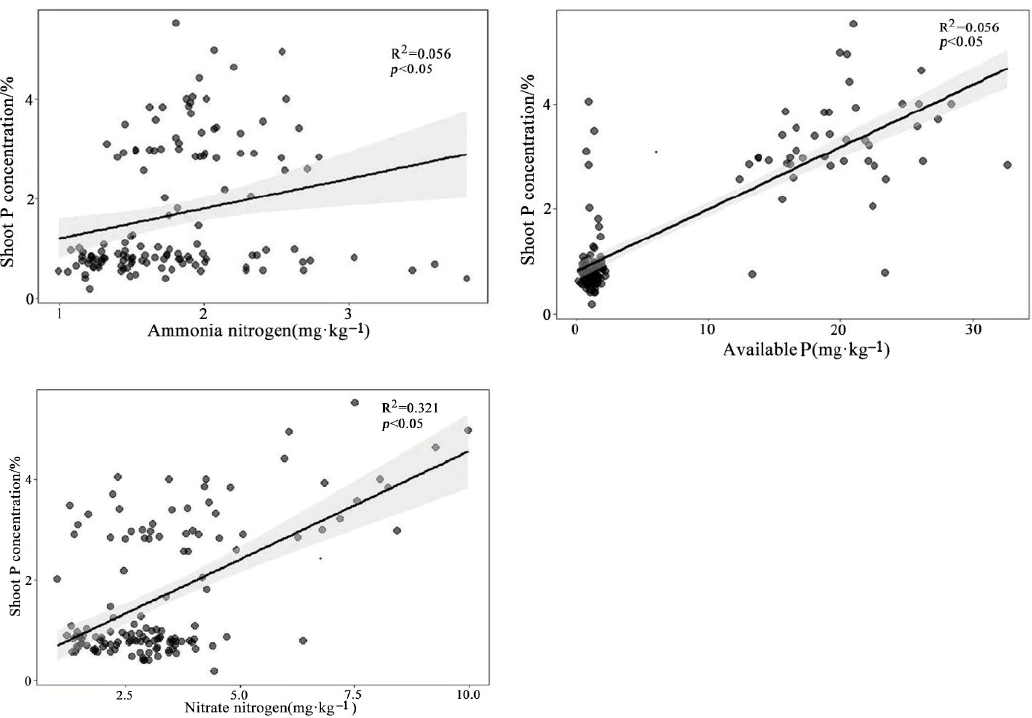
− -N contents in soil and plant + -N, and NO 3